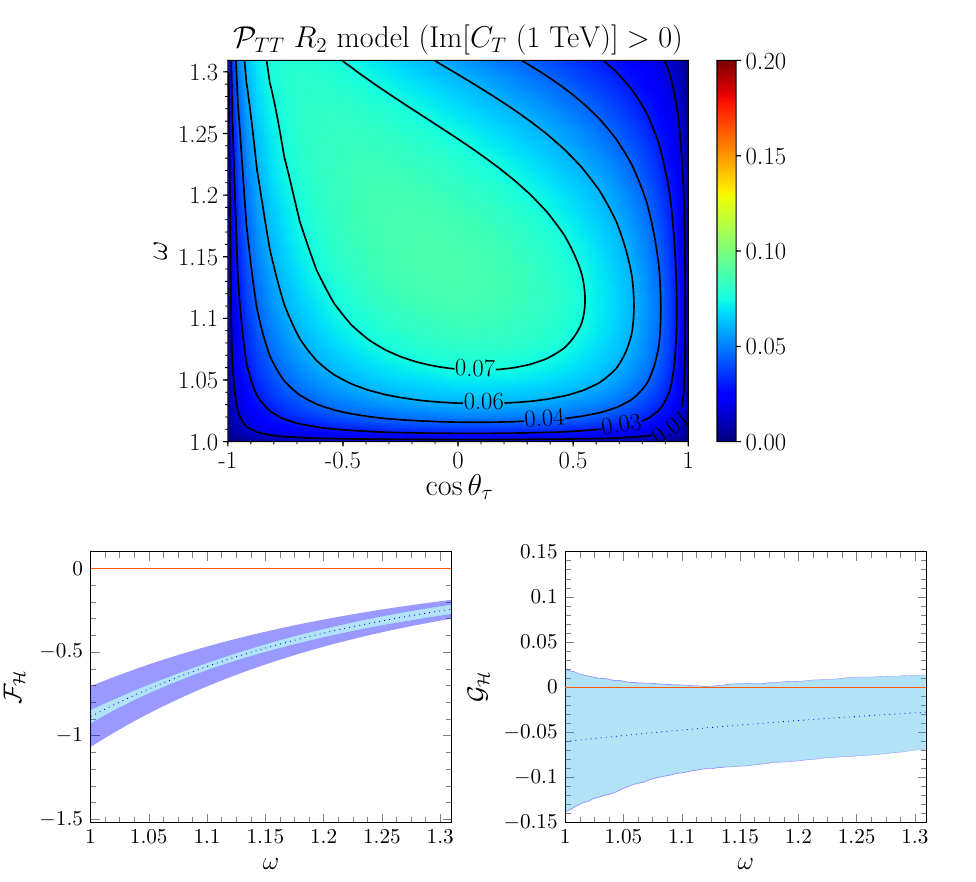
Figure 1 . Results for Λ b (cid:209) Λ c τ ¯ ν τ evaluated with the R 2 leptoquark model of ref. [39], for which the two nonzero Wilson coefficients ( C S and C T ) are complex. The unconstrained sign LL LL of Im r ˆ C 1 TeV qs is taken to be positive. The alternative choice Im r ˆ C 1 TeV qs (cid:160) 0 would not T p T p change the absolute values of the observables shown in this figure, but only their global signs. Top: two dimensional CM/LAB P polarization (eq. (3.21)) as a function of ω and the CM cos θ TT τ variable. The polarization component is obtained using the central values for the form factors (see details in section 4 below or in ref. [54]) and Wilson coefficients. Bottom: F (left) and G H p ω q H p ω q (right) scalar functions entering in the definition of the CP-violating N term of the differential H 3 decay width (eqs. (2.12) and (2.13)). The error inherited from the form-factor uncertainties is evaluated and propagated via Monte Carlo, taking into account statistical correlations between the different parameters, and it is depicted as an inner band that accounts for 68% confident-level intervals. The uncertainty induced by the fitted Wilson coefficients is determined using different 1 σ statistical samples configurations by the authors of ref. [39]. The two sets of errors are then added in quadrature giving rise to the larger uncertainty band. Note that uncertainties on G H p ω q are largely dominated by the errors due to the